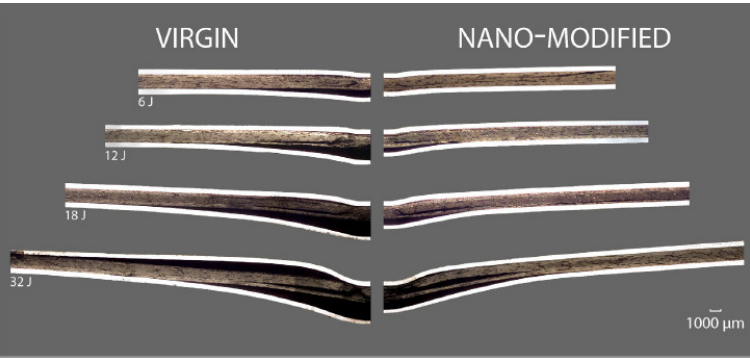
Figure 5. The effect of nanofibers on decreasing damage in GLARE [29] .